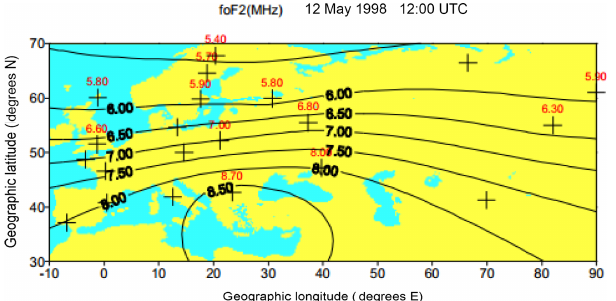
Figure 6. Map derived from measured values of fo F2 for 12 May 1998 at